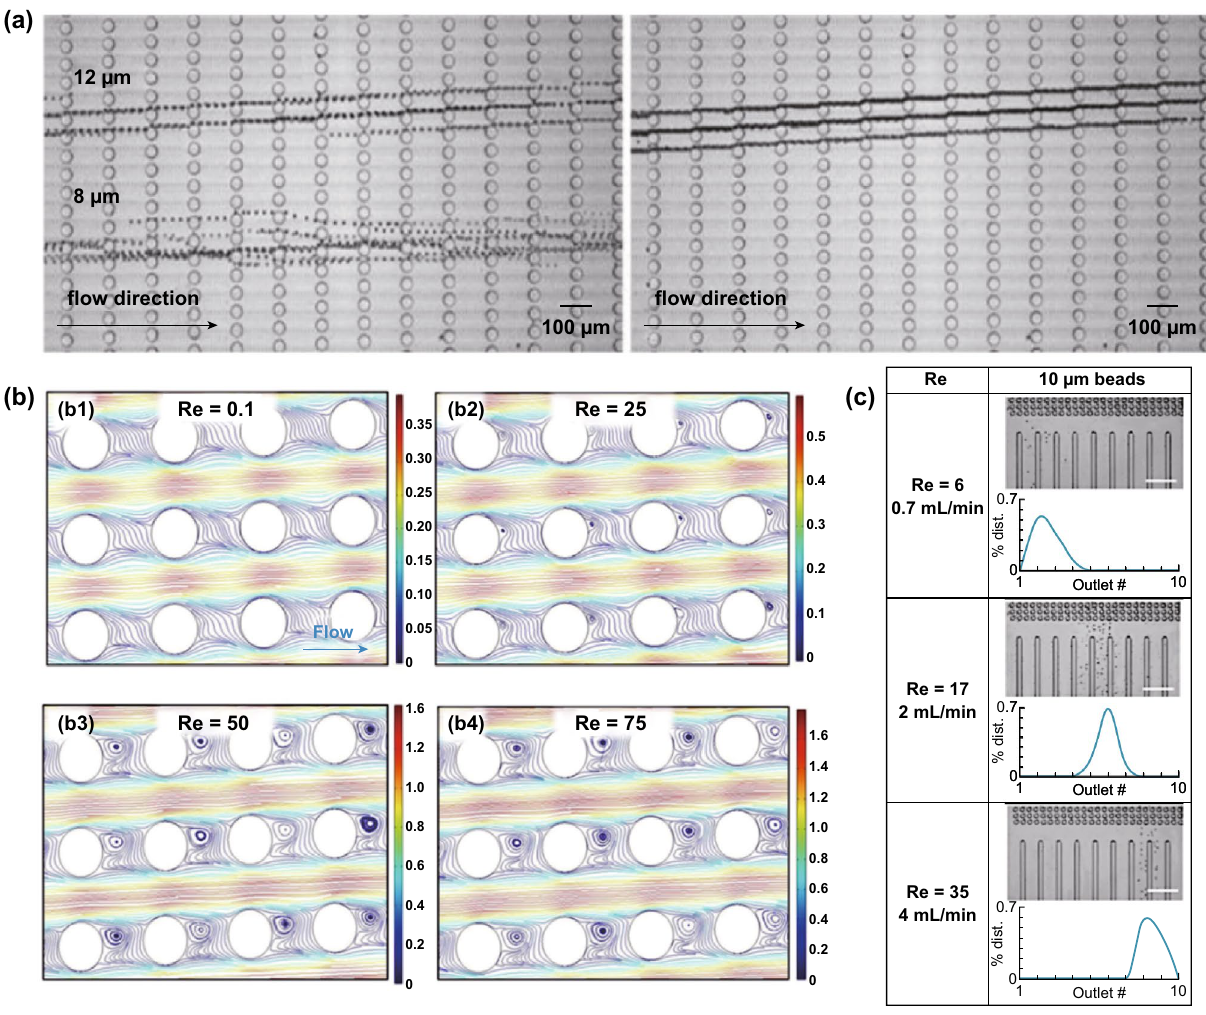
Fig. 7 Modulation of the critical diameter using fluidic forces. a The modulation of critical diameters with viscoelastic fluids at a low fluid flow rate (left) and high flow rate (right) [48]. b The effect of high Reynolds numbers on the development of microvortices [49]. c The tuning of the critical diameter using different Reynolds number flows [49]. Figure panels reproduced from Ref. [48] with permission from Springer Nature (CC BY 2018), Ref. [49] with permission from Springer Nature, copyright